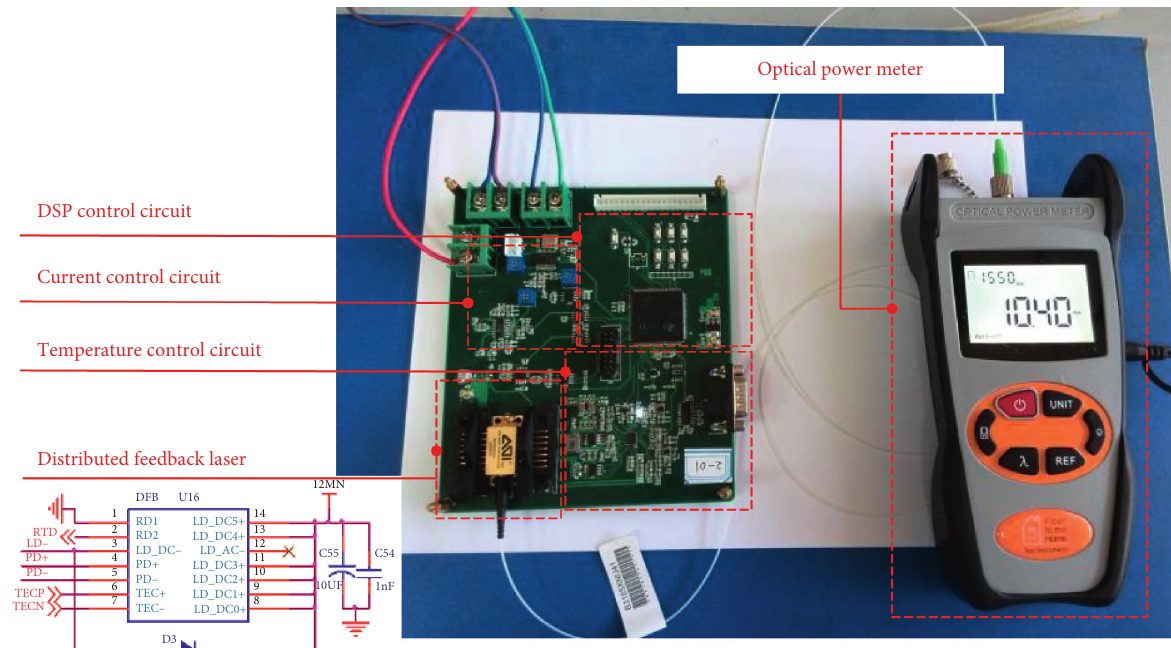
Figure 7: Photo of the developed laser driving circuit and optical power test.